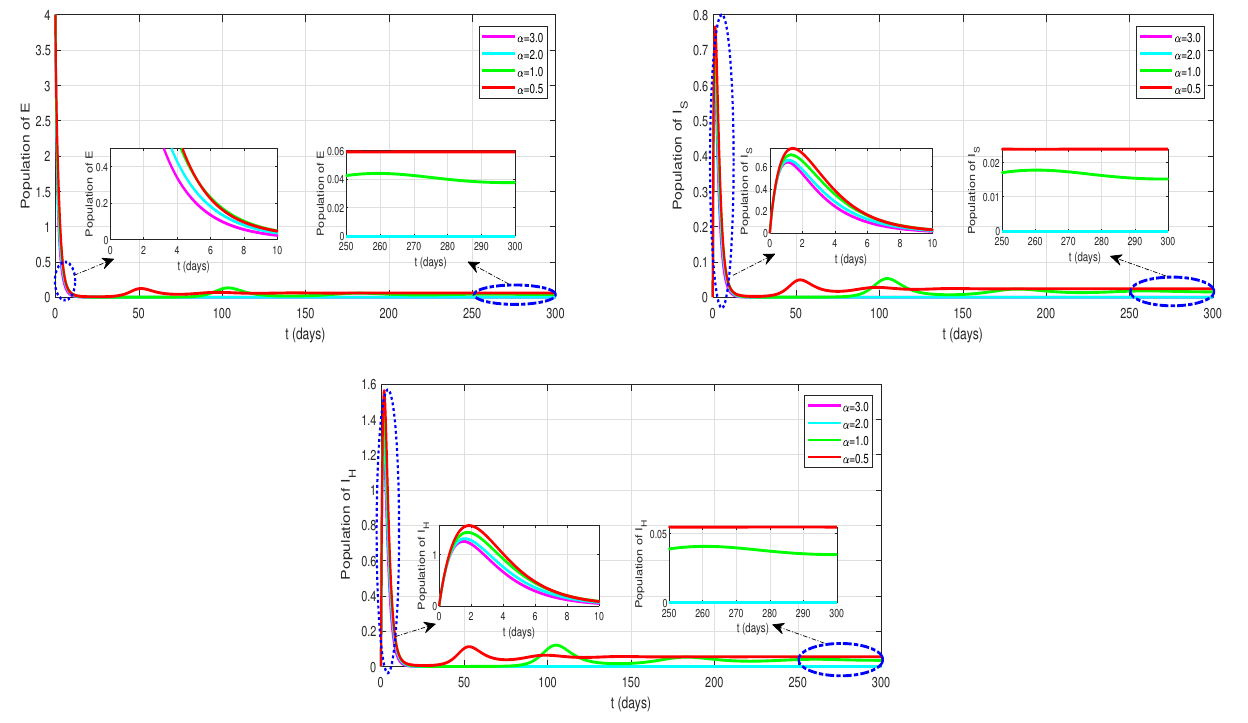
Figure 4. Dynamics of E , I S , and I H for α = 0.5,1.0,2.0 and 3.0 showing the impact of saturated incidence rate.